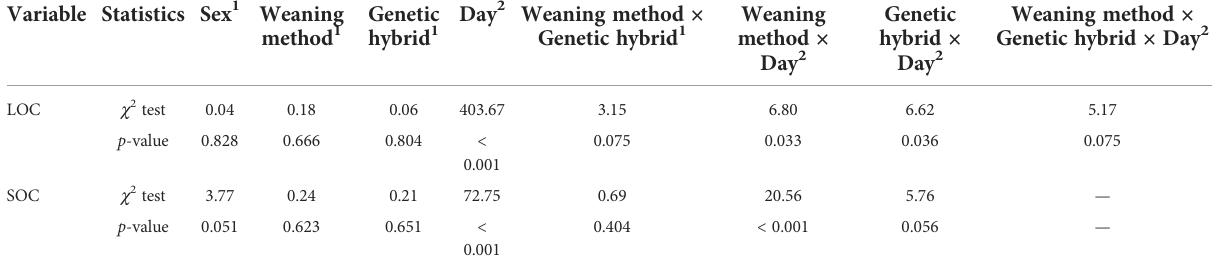
TABLE 4 Test statistics ( c 2 test) and p -values for the duration (s/pig/8-h) of locomotor-rotational play (LOC) and social play (SOC) in weaner pigs used in a 2 × 2 factorial arrangement of treatment factors: weaning method (litters mixed in a conventional weaning pen; MOVE vs. litter stayed in the farrowing pen after removing the sow; STAY) and genetic hybrid (DanBred; DB vs. Topigs Norsvin TN70; TN), on days − 1, 1, and 2 relative to the weaning day. Variable Statistics Sex 1